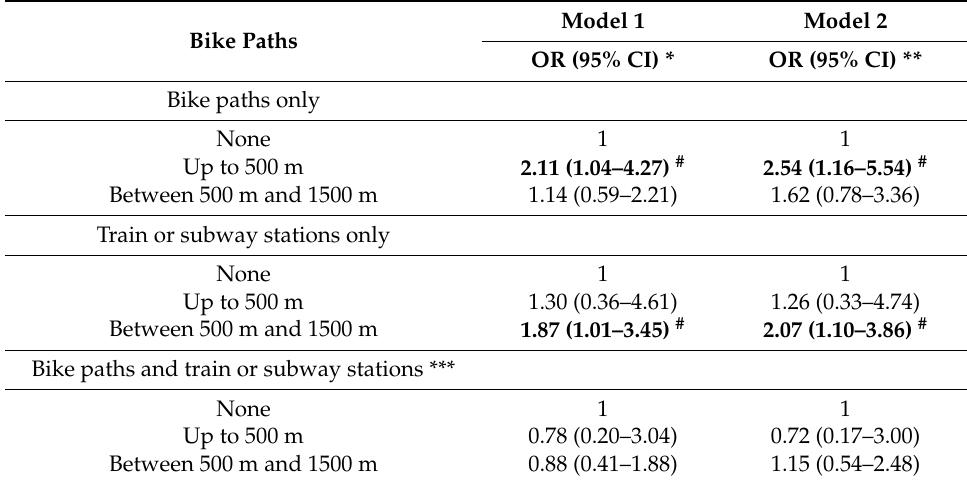
Table 3. Results of the multilevel model for the association between cycling for transportation with bike paths and train or subway